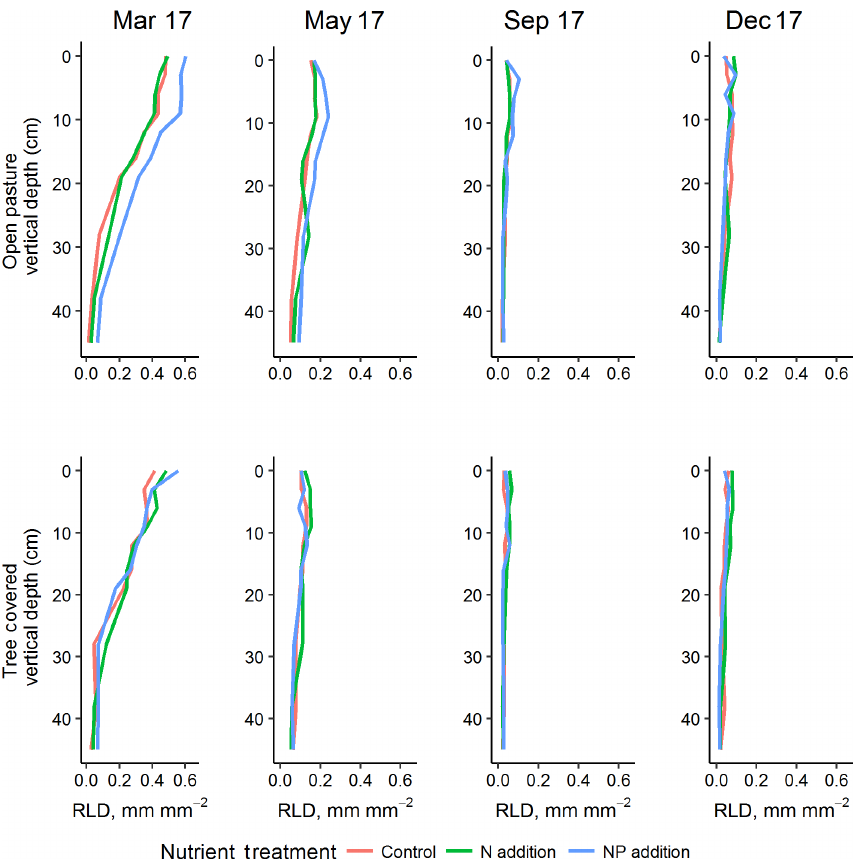
Figure 5. Vertical root profiles (mean of minirhizotron measurements) for the four sampling dates in 2017, representing one complete annual cycle (peak RLD in March of this year was also higher than 2018). +NP treatments tended to diverge in the grassland, especially in surface soils where RLD was highest. Treatment effects were most evident in the shallow soil depths where root biomass was